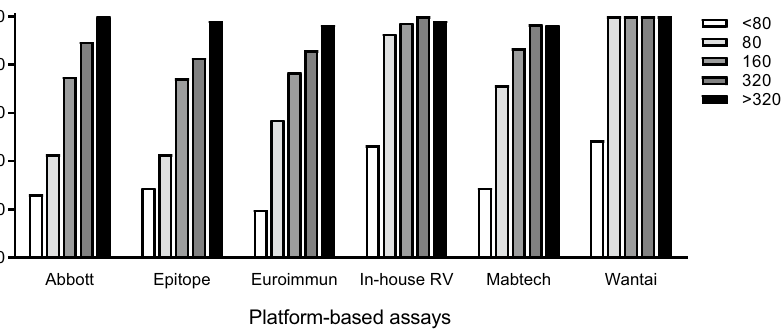
Platform-based antibody